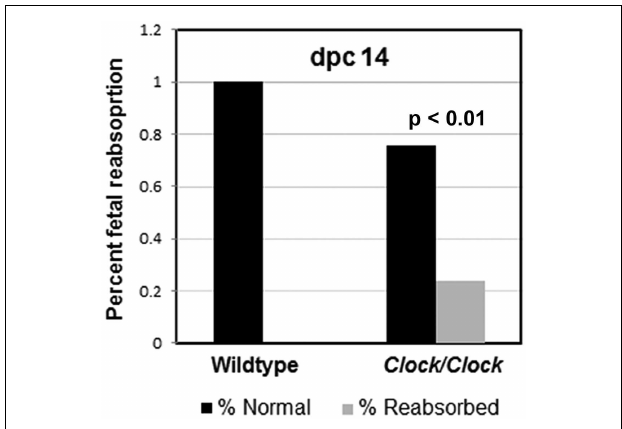
FIGURE 5 | Clock/Clock pregnancies exhibit abnormal fetal reabsorption . In Clock mutants that do become pregnant, the early stages of pregnancy, including ovulation, implantation, and embryonic development appear normal. However, by mid-pregnancy, Clock/Clock females exhibit a significant increase in fetal reabsorption. Modified from data presented in Ref. (17).